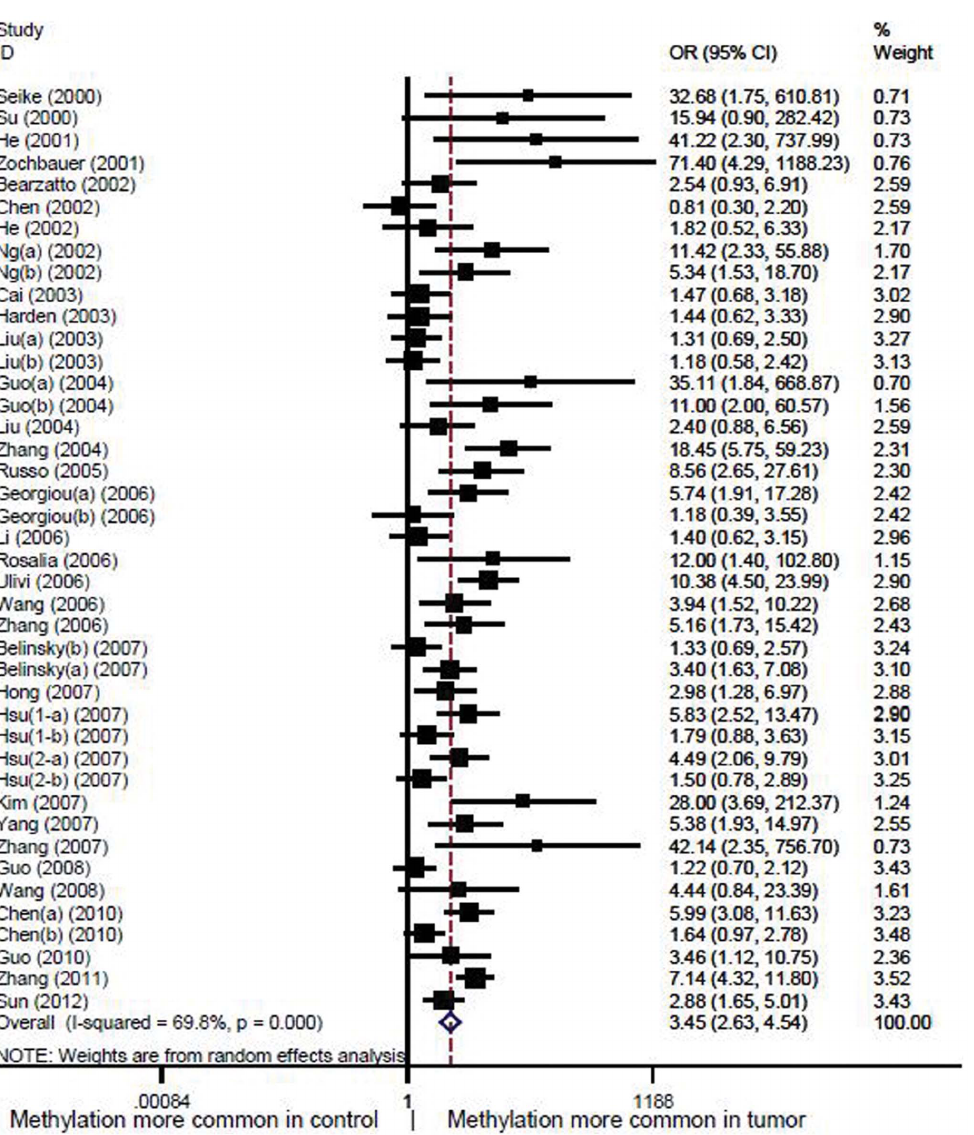
Figure 2. Forest plot of P 16INK4A promoter methylation in cancer tissue versus autologous controls. The squares and horizontal lines represent the study-specific OR and 95% CI. The area of the squares reflects the weight (inverse of the variance). The diamond represents the pooled OR and 95% CI.